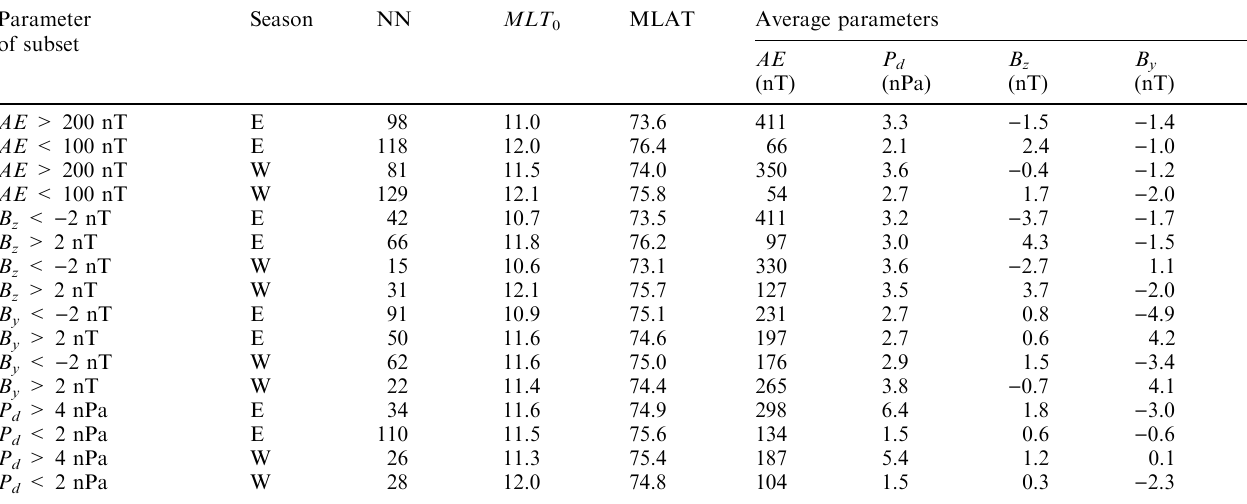
Table 2. Phase ( MLT ) and maximal corr.geom.latitude (MLAT) of the isotropic boundary cosine fit for subsets ordered by interplanetary 0 parameters or activity indices for equinox (E) and winter (W) seasons MLAT Average parameters Parameter Season NN MLT 0 of